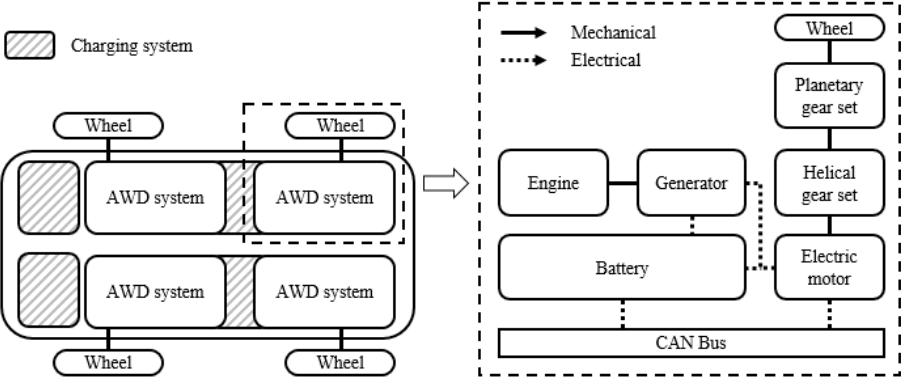
Figure 1. Schematic diagram of the power flow for the electric all-wheel-drive (AWD) tractor.